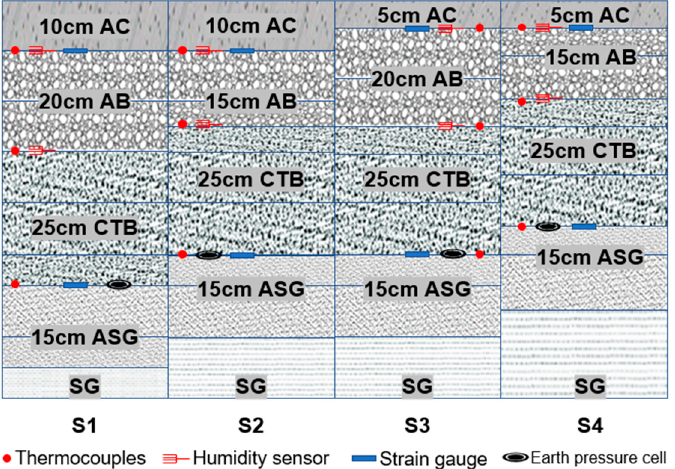
Figure 3. Structure combination and instrumentation design scheme of APT sections. Note: AC, AB, CTB, ASG, and SG denote the asphalt concrete, aggregate base, cement treated base, aggregate subgrade, and subgrade, respectively.